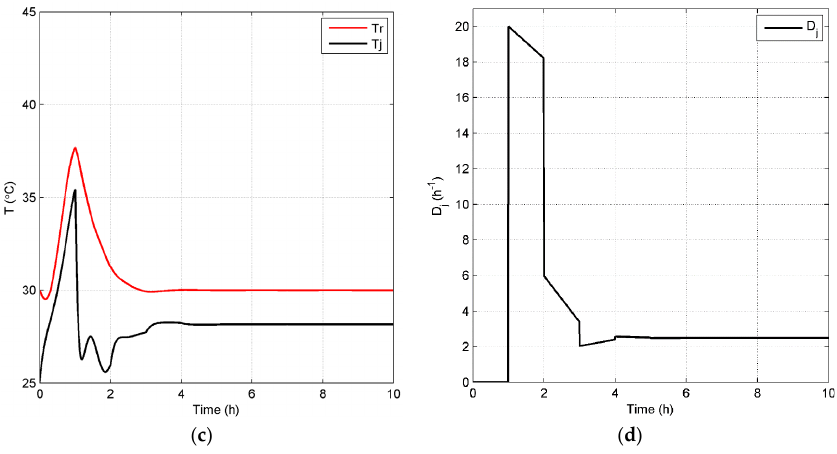
Figure 12. Closed-loop simulation profiles (Case 4): concentrations ( a ), D m,in ( b ), temperatures of the fermentor and jacket ( c ) and D j ( d ).